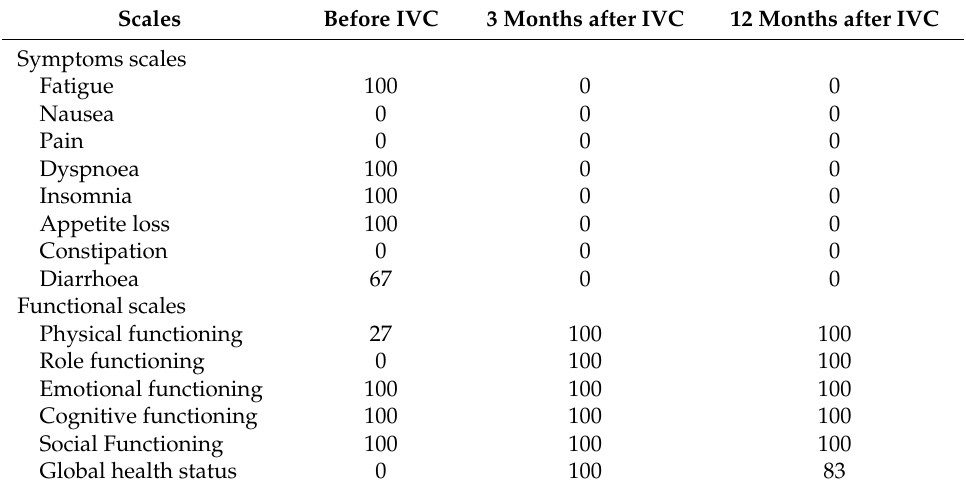
Table 2. Health-related quality of life following intravenous vitamin C (IVC) treatments. Scales Before IVC 3 Months after IVC 12 Months after